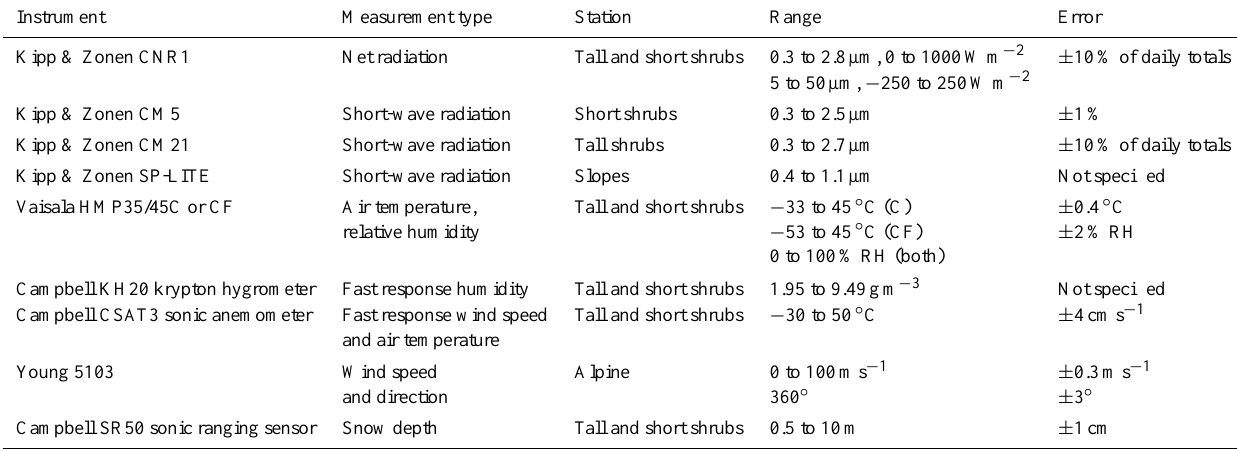
Table 1. Specifications of the instruments most relevant to this study whose measurements were used to compile forcing meteorological data for DBSM and 3SOM.